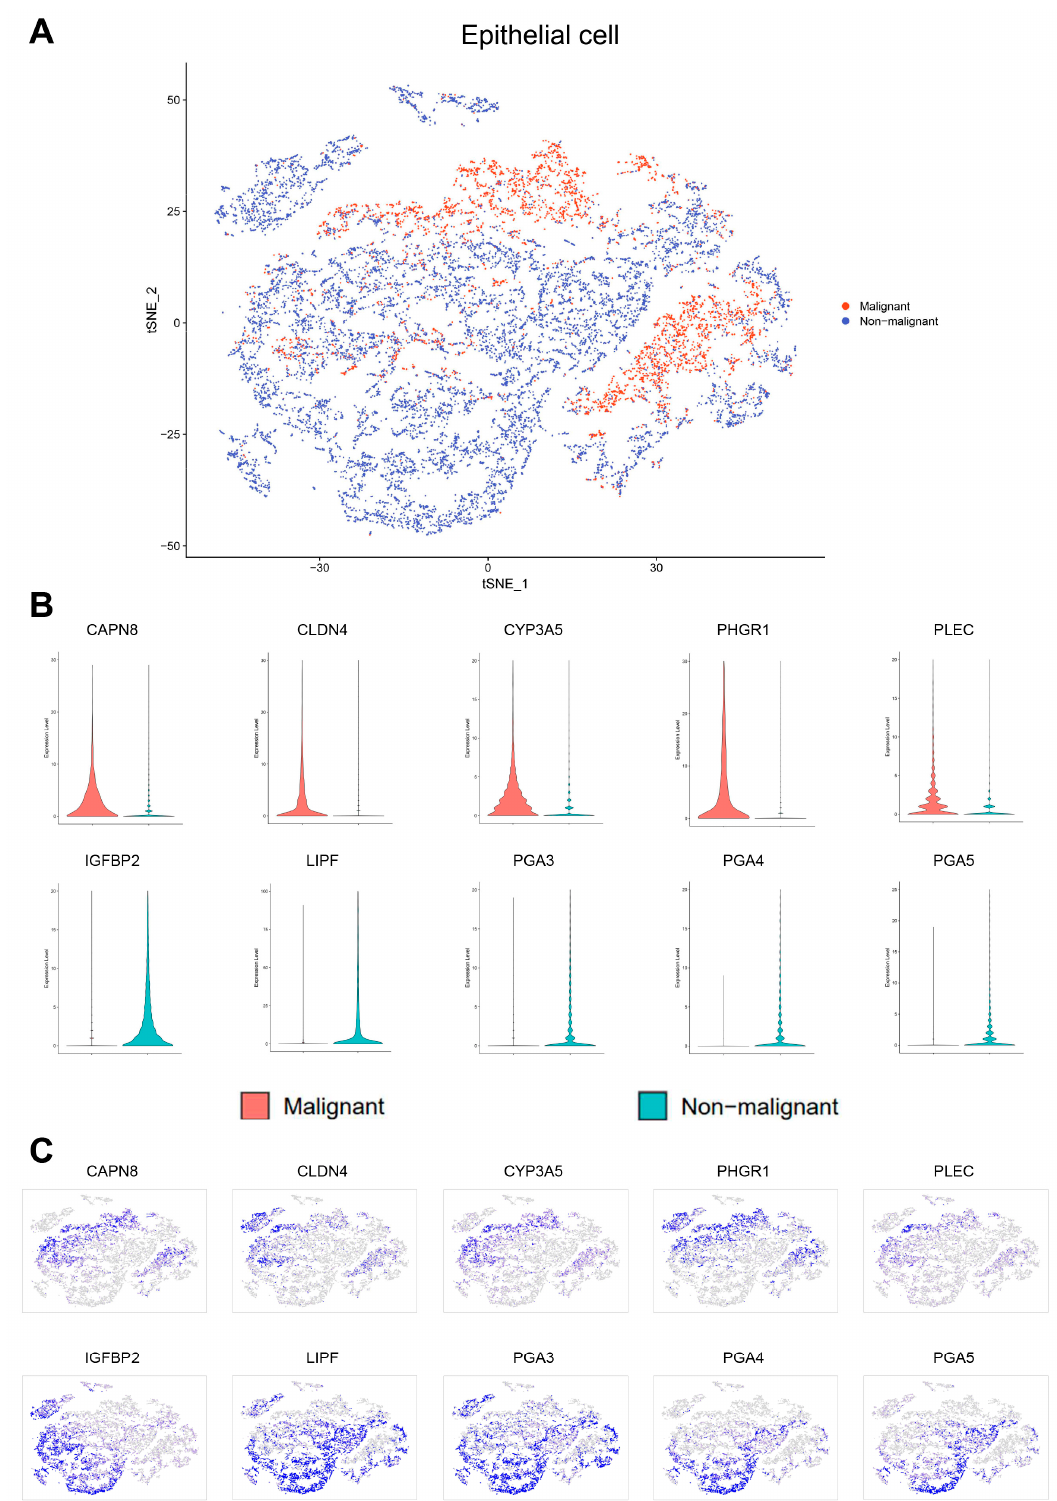
Figure 3. Copy − number variation analysis of epithelial cells. ( A ) tSNE plots showing the Seurat cluster and status of epithelial cells. ( B ) Hierarchical heatmap showing large − scale CNVs in the ep- ithelial cells of a primary tumor and in normal tissues. ( C ) Hierarchical heatmap showing the results of k − means class clustering. ( D ) Violin plots showing CNV scores in the different k − means classes. ( E ) tSNE plot showing the epithelial cells in the different k − means class clusters.